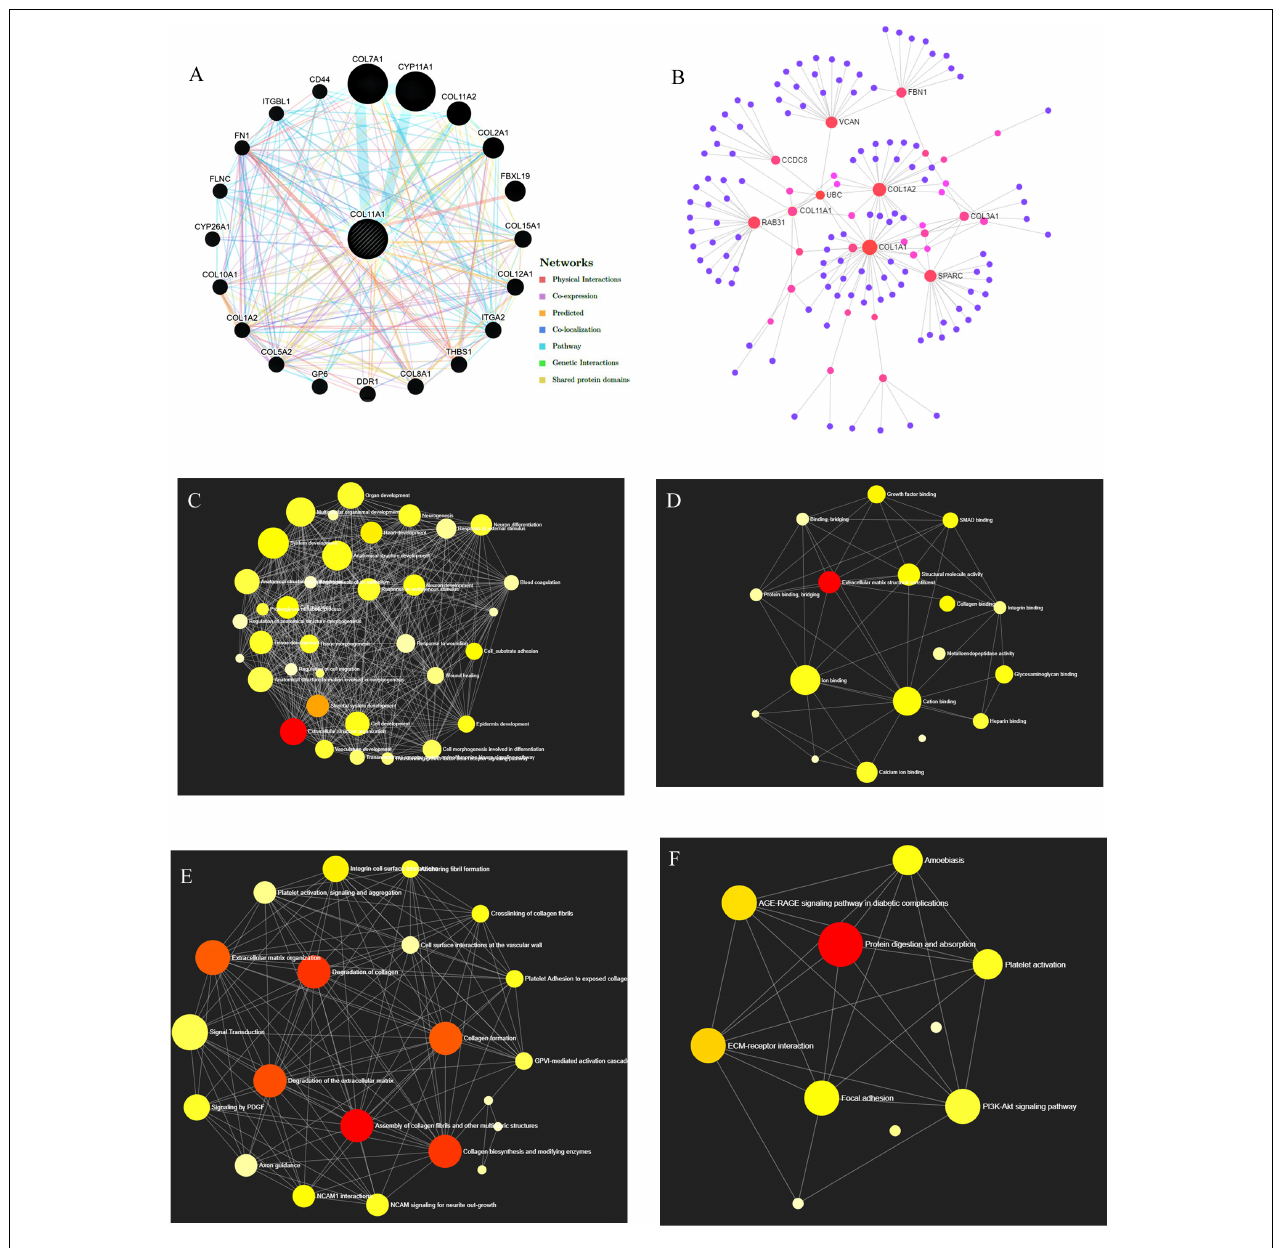
FIGURE 6 | Gene Network Analysis. (A) COL11A1 gene with its neighboring genes showing physical interactions (67.64%), coexpression (13.50%), predicted (6.35%), co-localization (6.17%), pathways (4.35%), genetic interaction (1.40%), and shared protein domains (0.59%) (B) Protein-protein interaction network based on IMEx protein interactions database. (C–F) Network enrichment analysis for (C) GO: Biological process, (D) GO: Molecular function, (E) Reactome pathways, and (F) KEGG pathways.